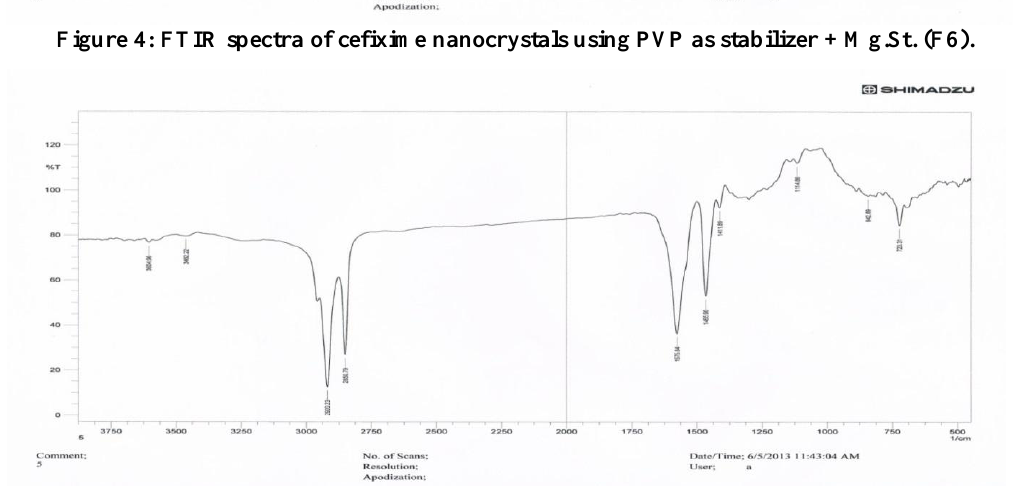
Figure 4: FTIR spectra of cefixime nanocrystals using PVP as stabilizer + Mg.St. (F6).